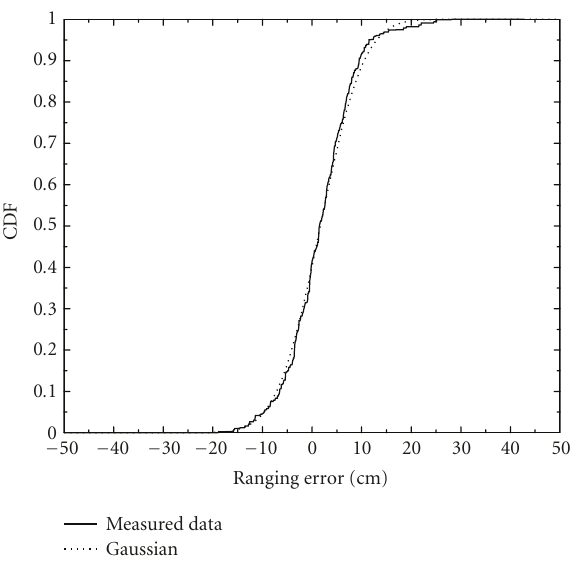
Figure 3: CDF of the ranging error for the LoS condition. Comparison with the Gaussian